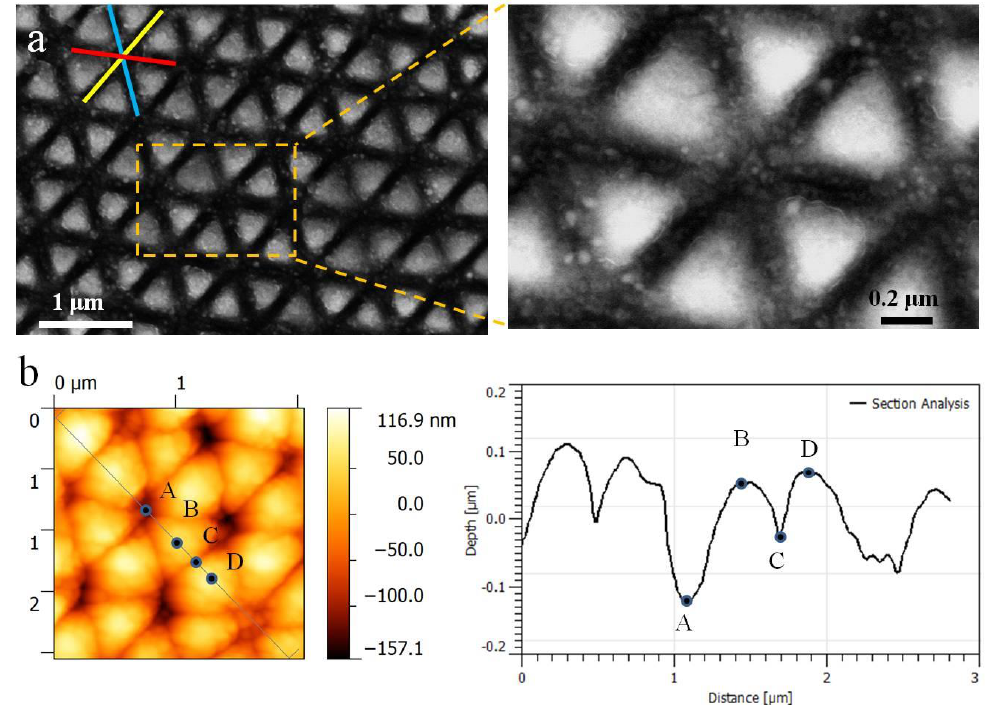
Figure 2. ( a ) SEM images of 2D periodic subwavelength triangular structures on tungsten surfaces induced by two time-delayed femtosecond laser beams with orthogonal polarizations. The laser energy and the sample scanning speed are E = 0.18 mJ and 0.03 mm/s, respectively; ( b ) AFM measurement results (including a cross-section profile) of the laser-induced triangular surface structures, where A, B, C, and D represent different positions on the structure surface.